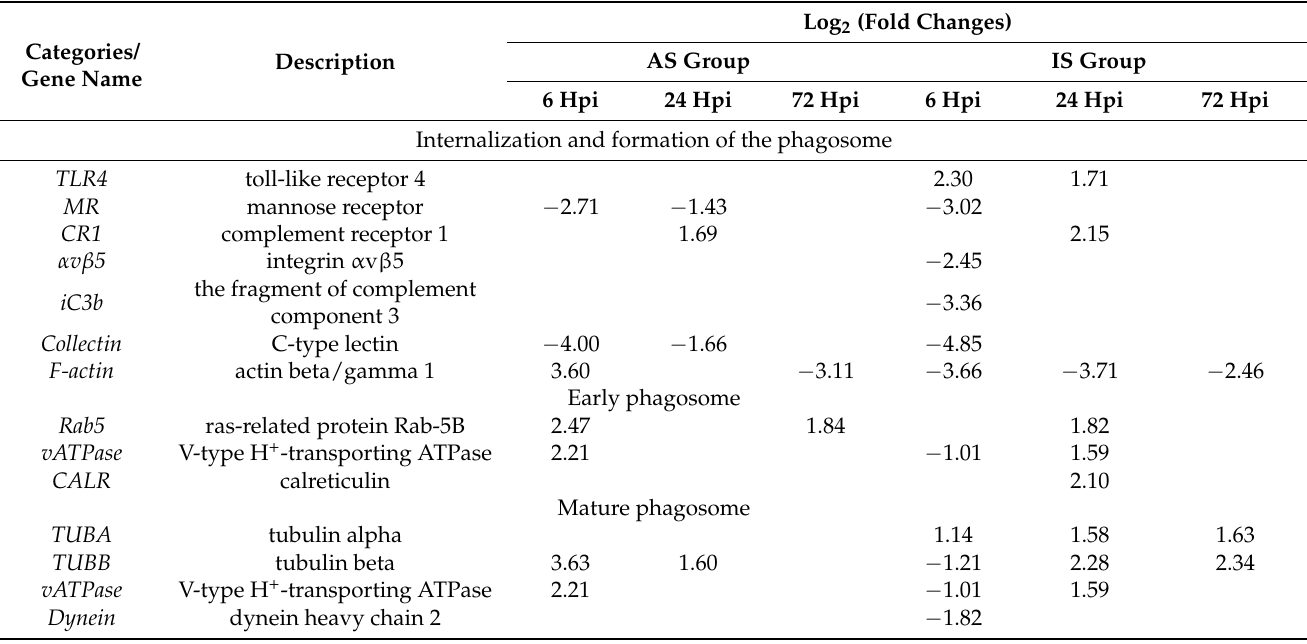
Table 5. Fold changes of differentially expressed phagocytosis-related genes in the AS group and the IS group compared to the